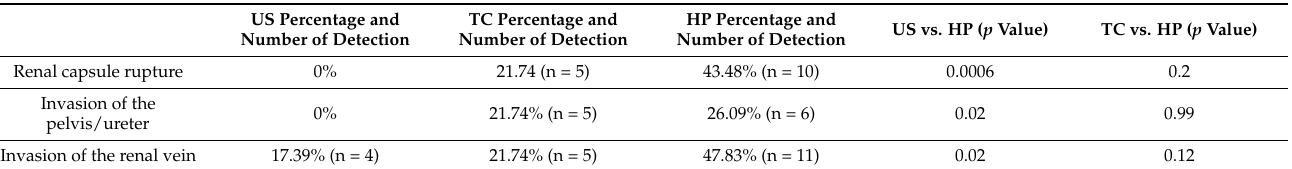
Figure 9. Renal vein invasion evaluation by US/CT comparative to histopathological examination.